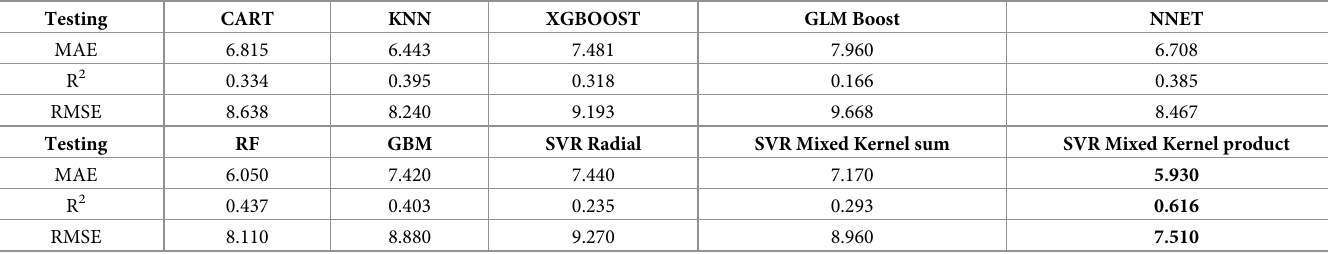
Table 3. Testing performance comparison for different algorithms. Testing